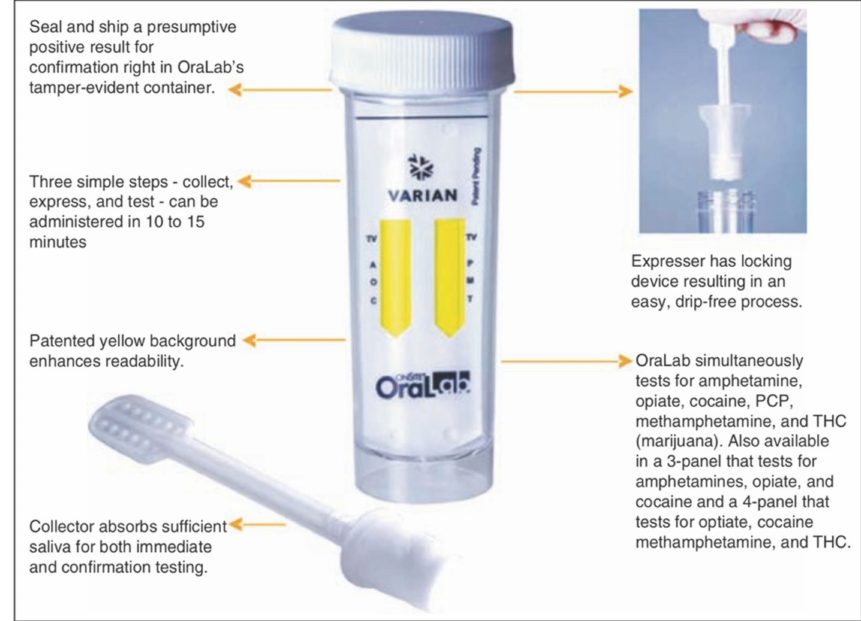
Figure 8. Varian OraLab (reproduced with permission from Springer [51]).